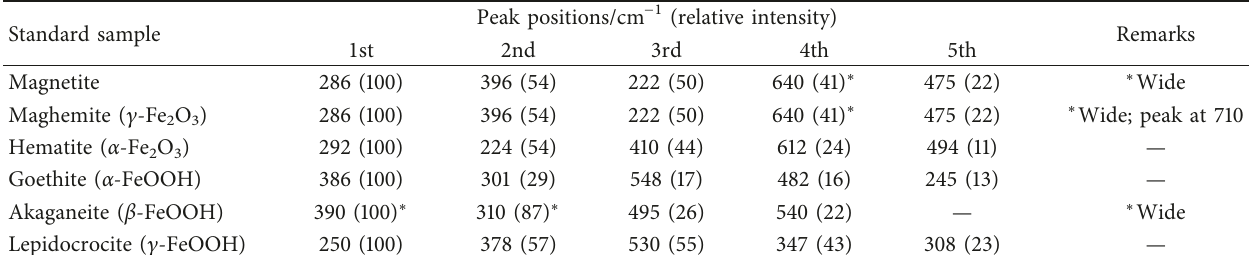
Table 3: Summary on the peaks observed from the Raman spectra of standard samples of iron rust. Standard